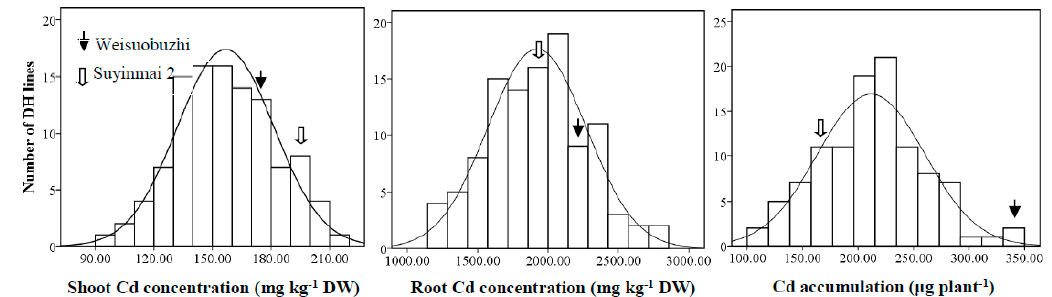
Figure 1. Frequency distribution of cadmium (Cd) concentration in shoots and roots, and Cd accumulation per plant. Parents and 108 DH lines were grown in a nutrient solution containing 10 µM CdCl 2 for 15 days. The data are represented as the mean of three replicates obtained from the spatial analysis. The solid arrow represents Weisuobuzhi (Cd-tolerant genotype) and the hollow arrow represents Suyinmai 2 (Cd-sensitive).